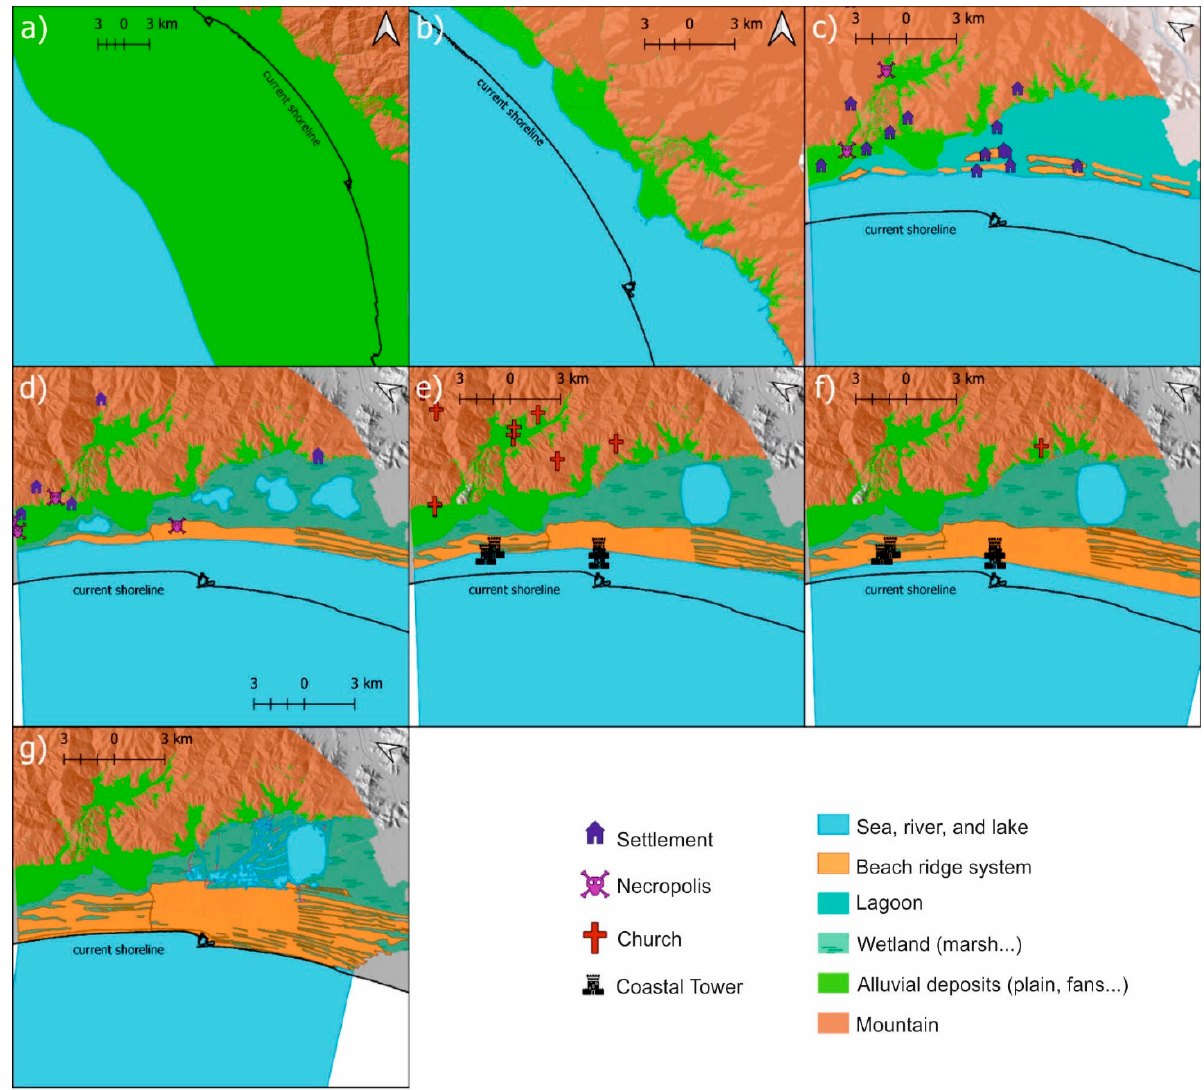
Figure 3. Reconstruction of the palaeoenvironment of ( a ) about 20,000 years B.P., ( b ) about 7000 years B.P., ( c ) Etruscan Age, ( d ) Roman Age, ( e ) Middle Ages, ( f ) Modern Age and ( g ) Contemporary